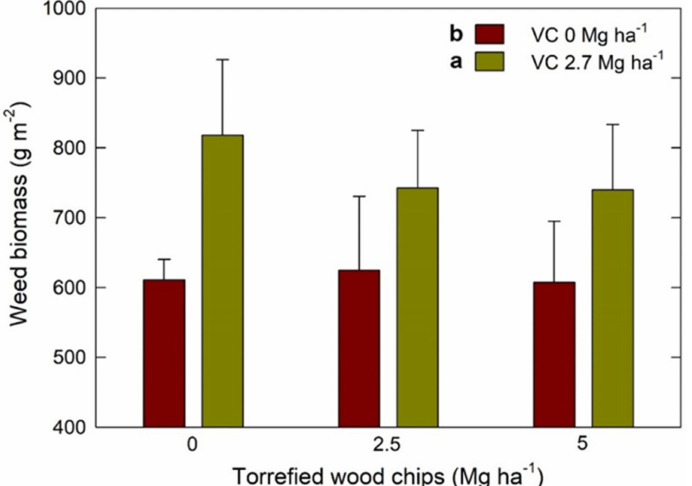
Figure 4. Biomass of weeds in the study site containing different amendments of the torrefied wood chips (TWC) and vermicompost (VC). The different lowercase letters ( a , b ) indicate significant differences across the VC treatments. The vertical bars indicate standard errors (n = 3).